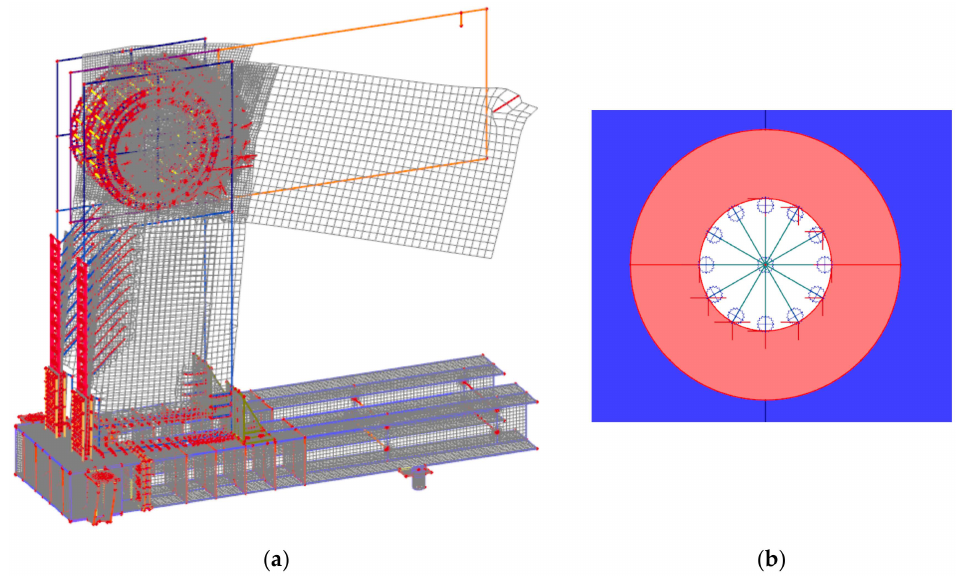
Figure 10. Computational model: ( a ) local stability; ( b ) detail of the mesh of finite